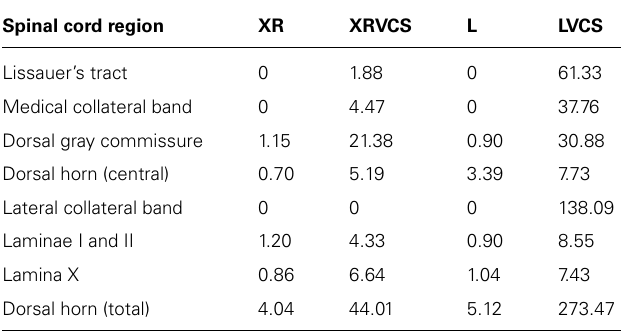
Table 1 | Regional distribution of median number of HRP particles/1 × 10 4 μ m 2